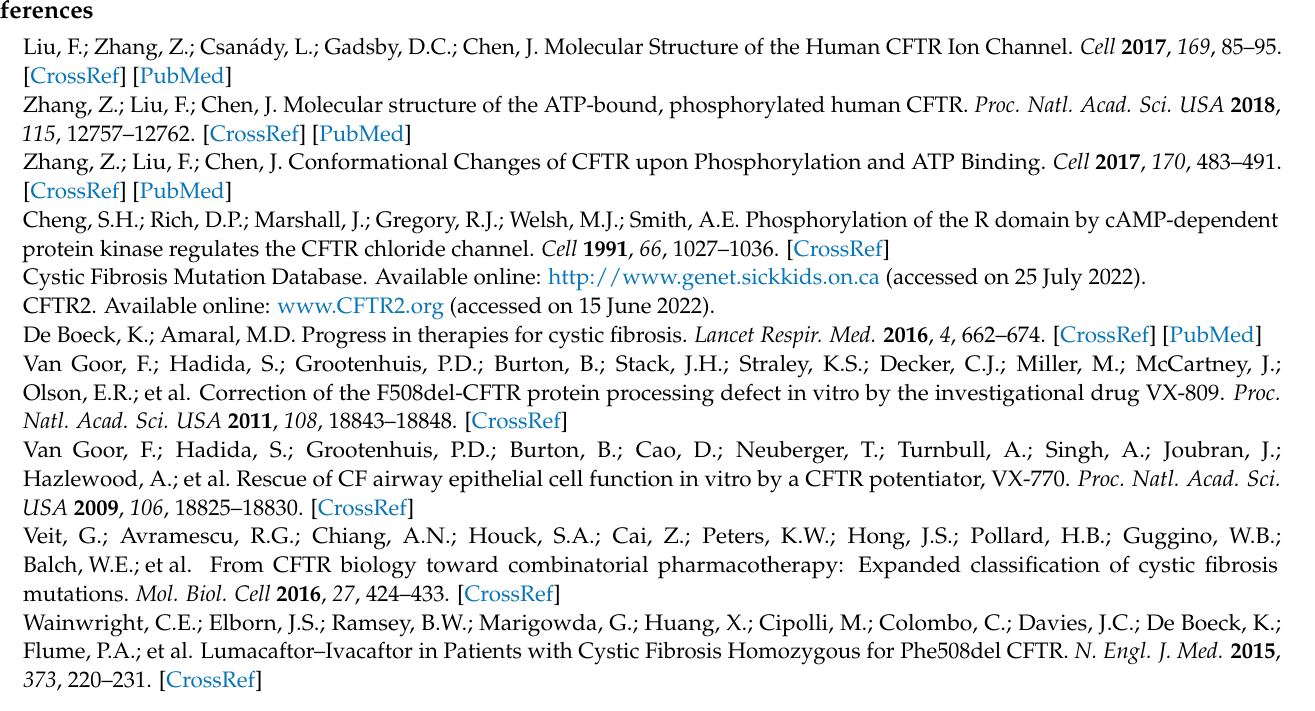
Sluijs lab for helpful